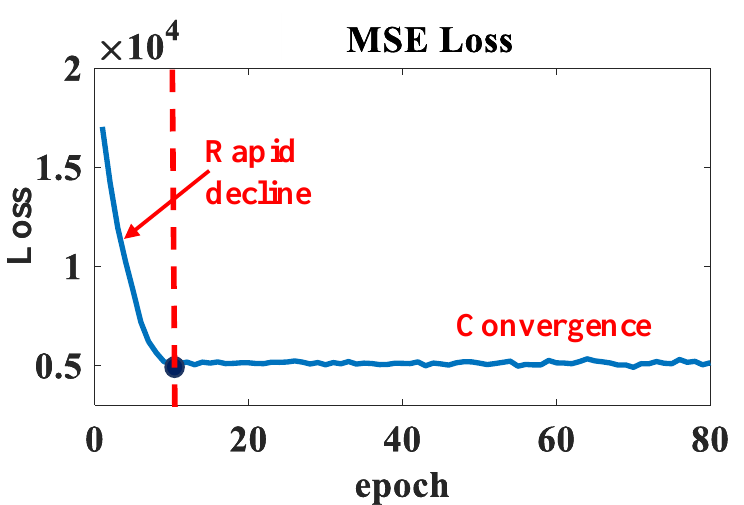
Figure 10. The loss function curve of the LSTM model training process. Two stages can be divided among the epoch of the loss function, which include the rapid decline stage and the convergence